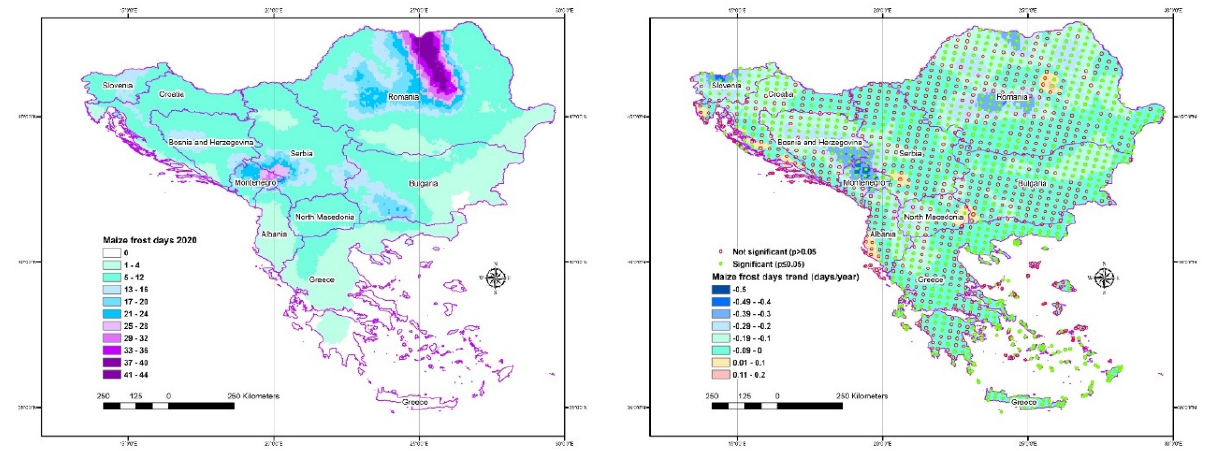
Figure 6. The distribution of frost days during the maize cultivation in 2020 ( left ) and the frost days’ trend with statistical significance marks ( right ).